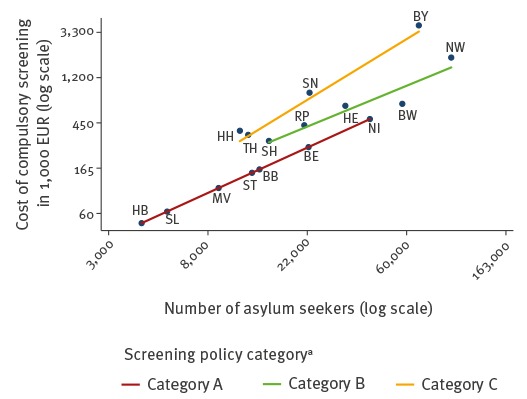
Scatter plot of estimated total costs of medical screening measures by number of asylum seekers and category of screening policy, Germany, 2015 (n = 441,899 first-time applicant asylum seekers)